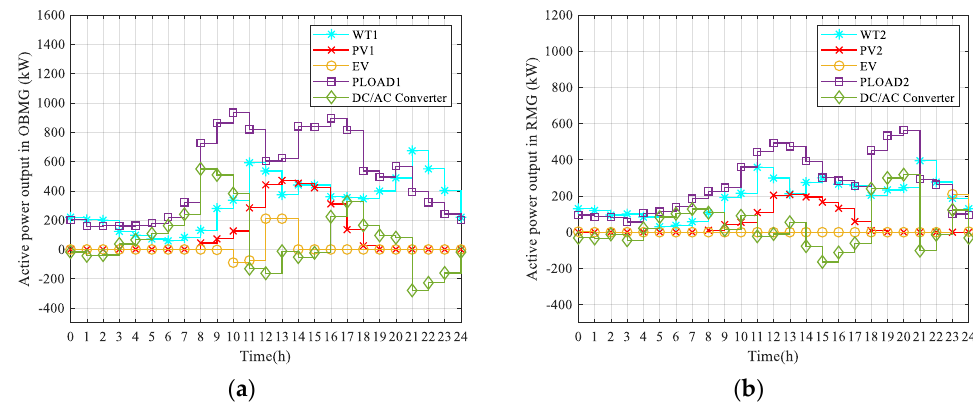
Figure 9. ( a ) Power output of RESs, EVs, and the DC/AC converter in OBMG; ( b ) power output of RESs, EVs, and the DC/AC converter in RMG.